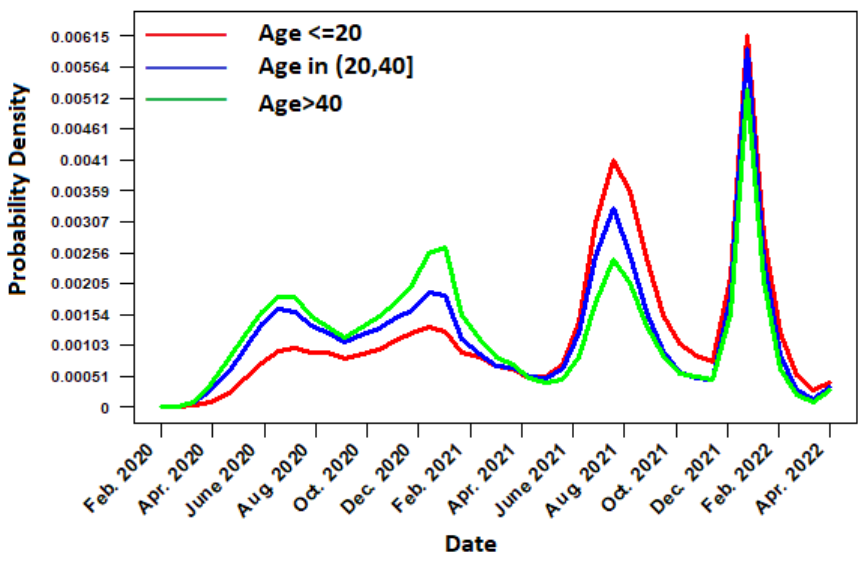
Figure 3. Temporal distribution function in terms of probability for daily COVID-19 cases by age.